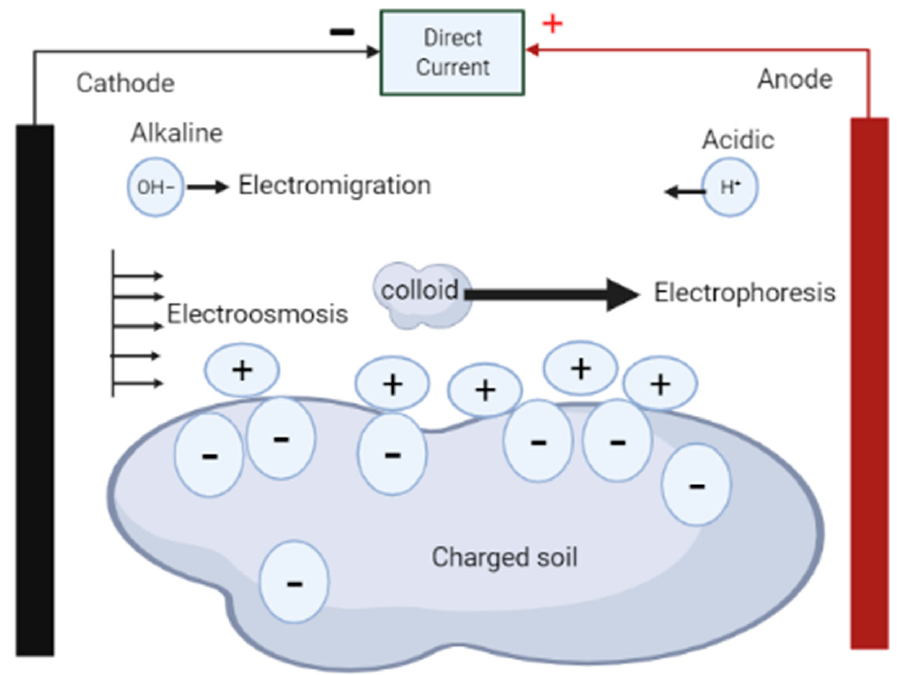
Figure 1. Fundamental transport mechanisms induced by the application of current.